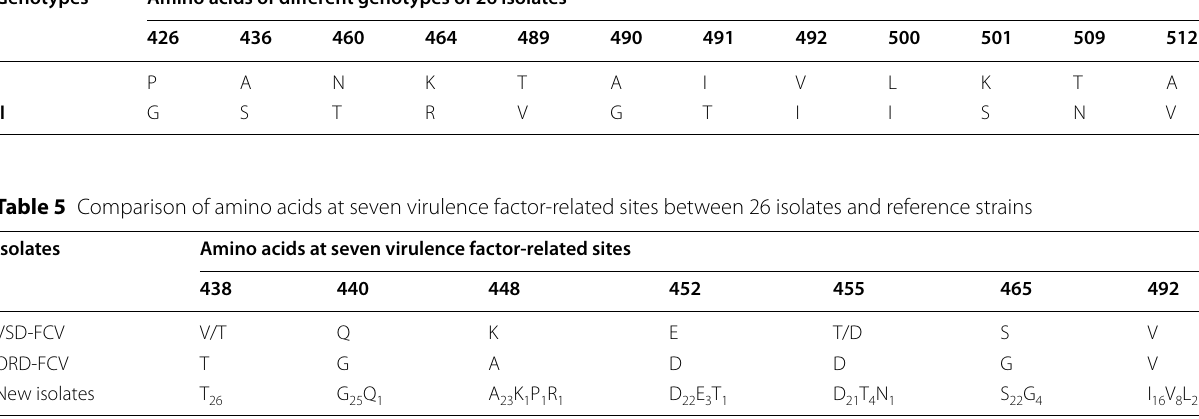
Subscripts indicate the frequency of occurrences among the 26 isolates